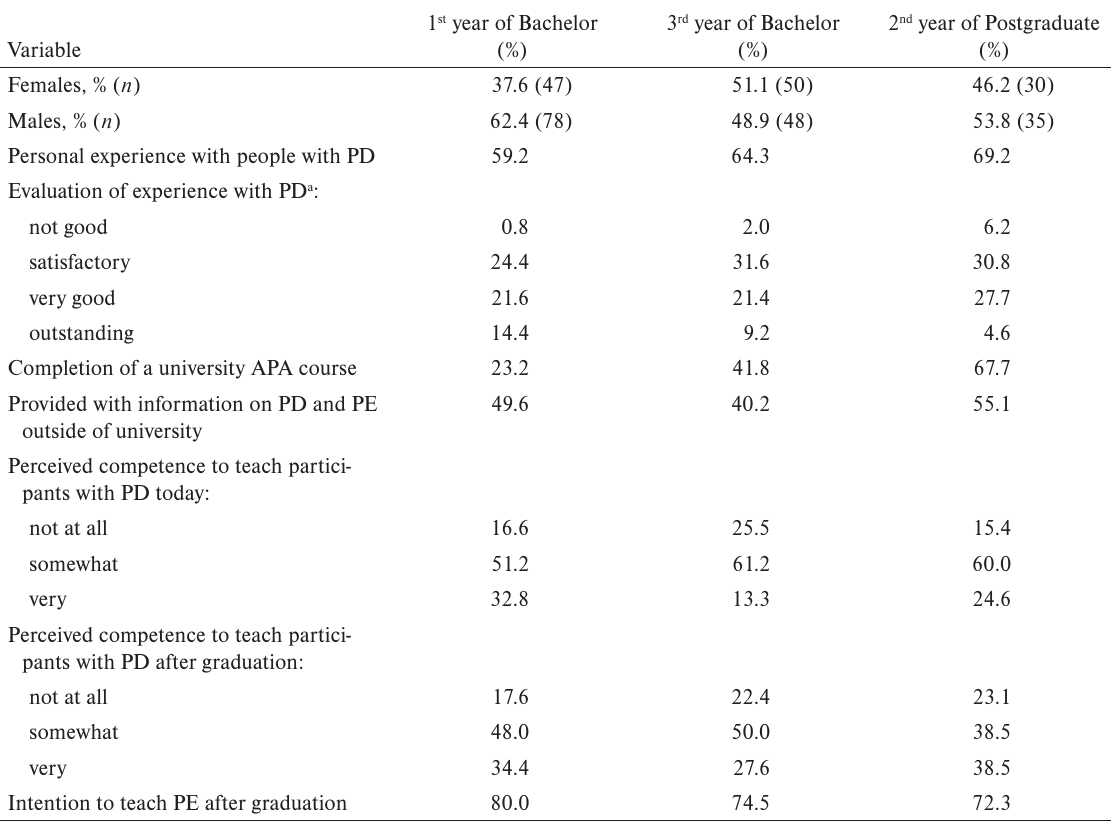
Demographic data: 1 st and 3 rd year of Bachelor, 2 nd year of